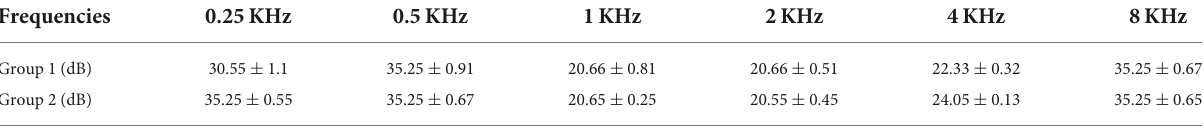
TABLE 4 The average preoperative differences in A-B gap of patients with type I labyrinthine fistulas in groups 1 and 2. Frequencies